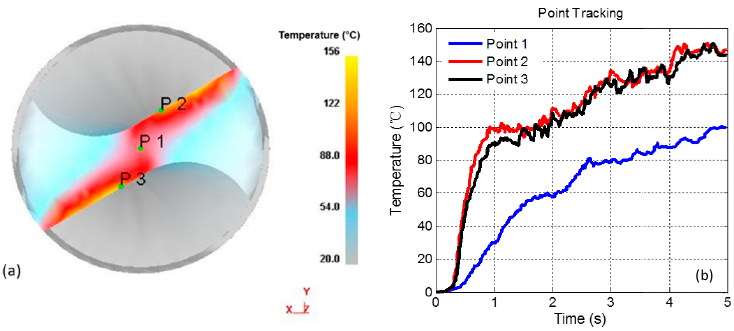
Figure 12. Particle tracking of tool temperature. ( a ) Three particle points marked on the drilling edge; ( b ) Temperature change of the three particle points.